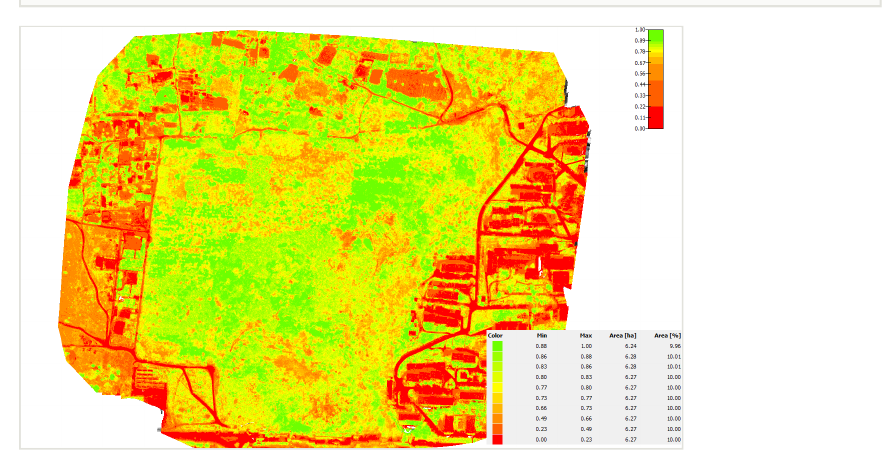
Figure 6. NDVI model of ‘Apostolova gora’ park (Min- minimal NDVI score for the class, max-maximal NDVI score for the class, area (ha) total area of the NDVI class, area (%)- relative share of the NDVI class within the studied